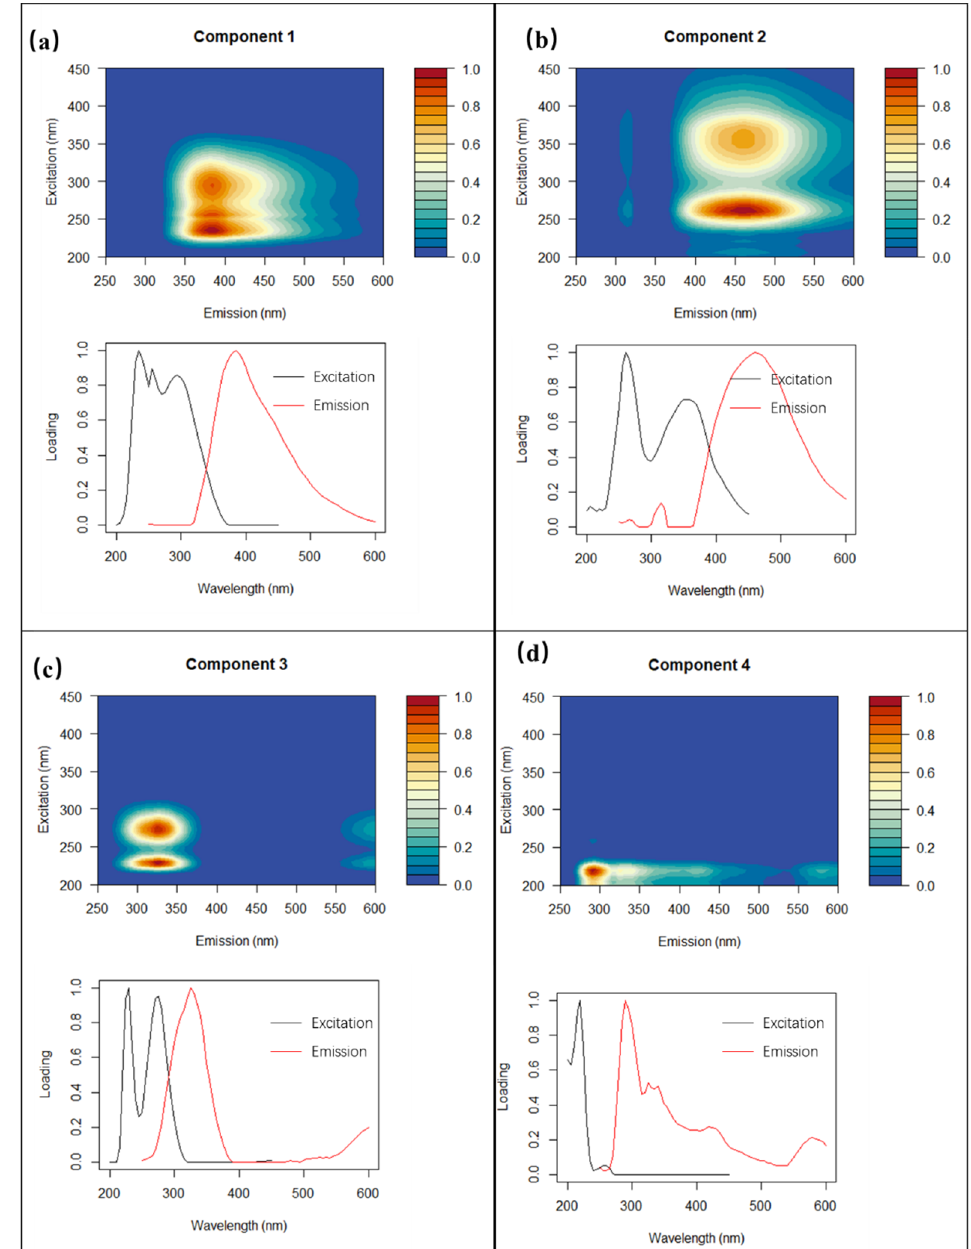
Figure 2. Fluorescent components identified by PARAFAC model. ( a ) Component 1, ( b ) Component 2, ( c ) Component 3, and ( d ) Component 4. The contour plots indicate the fluorescence signatures, and the line plots illustrate the spectral curves of excitation and emission of each component.